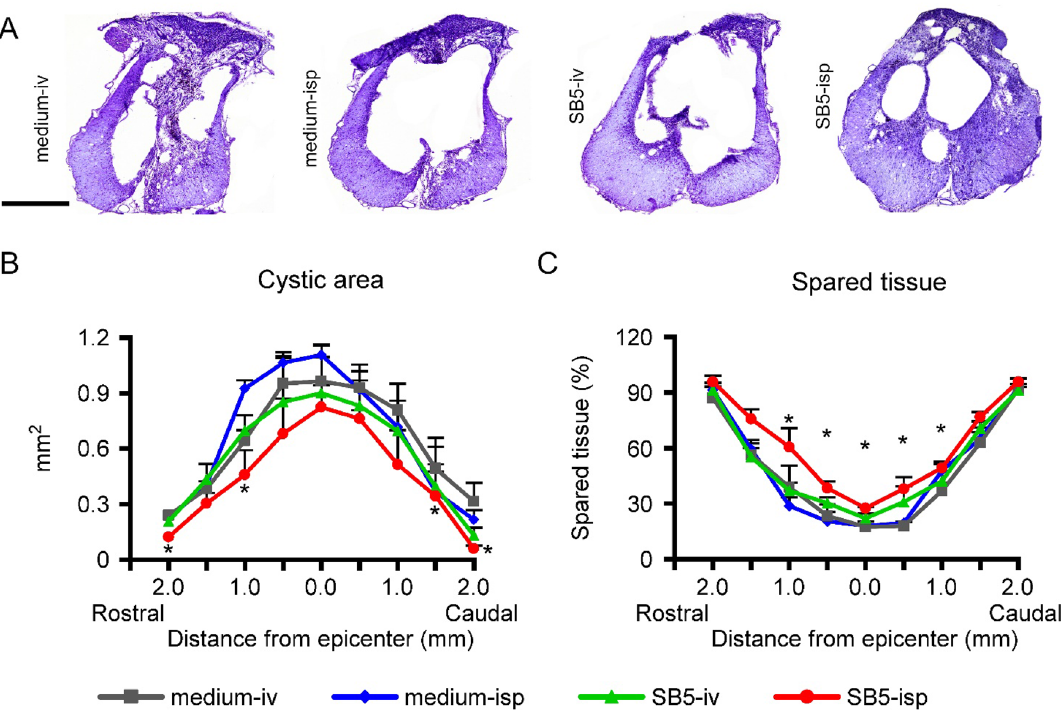
Figure 2. Intraspinally grafted hiPSCs promote tissue sparing. ( A ) Representative images taken at 100 μm rostral to the SCI lesion epicentre. ( B ) Quantification of cystic area shows that intraspinal hiPSC treatment resulted in considerably reduced size of injury following SCI. ( C ) Improved tissue sparing is seen rostro- caudally to the injury epicenter in the intraspinally grafted group ( SB5-isp ). Significantly more tissue sparing was detected in the intraspinally treated group ( SB5-isp group) compared with its control ( medium-isp ). Data are expressed as mean ± SEM. (n = 8 in each group) *significant difference between the intraspinally grafted animals ( SB5-isp ) and its control. Scale bar: 500